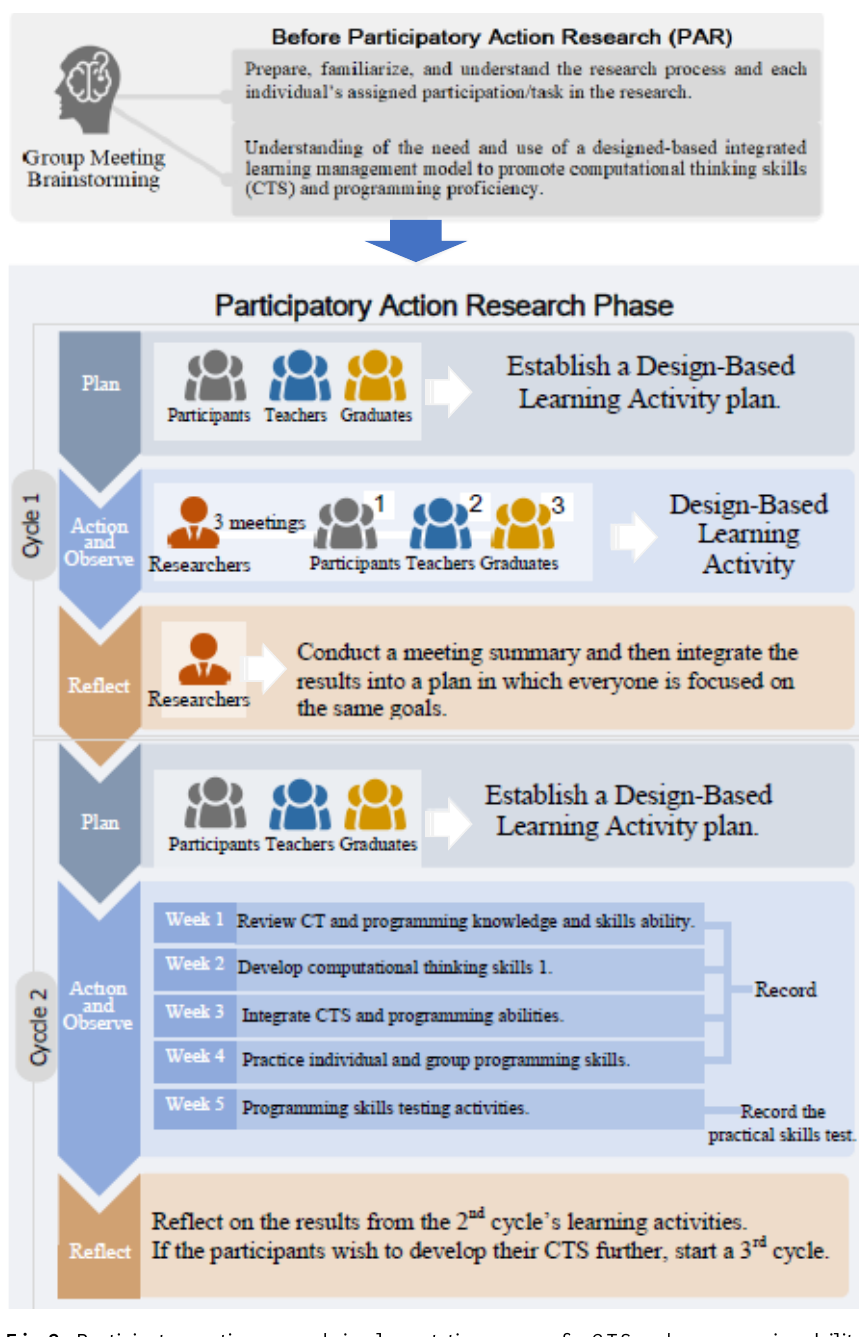
Fig. 2. Participatory action research implementation process for CTS and programming ability